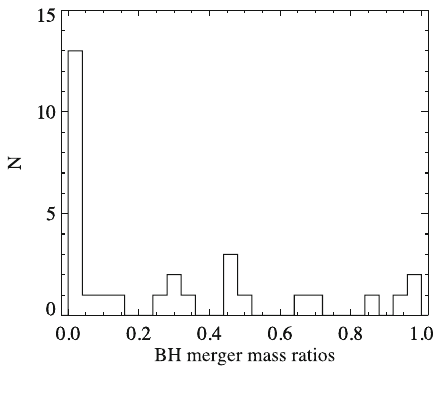
Fig. 32 Peak in IMBH/MBH mergers at mass ratios (cid:1) 20 :